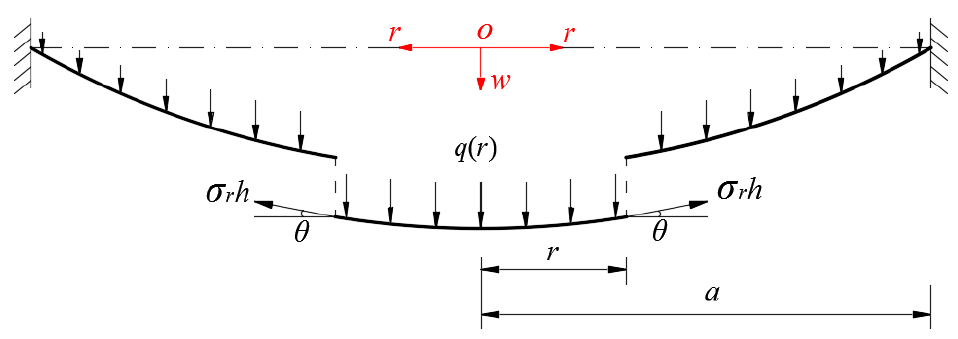
Figure 2. Free body diagram of the deformed circular membrane with radius 0 ≤ r ≤ a . Obviously, the external force F ( r ) produced by q ( r ) within radius r is equal to the weight of the liquid within radius r , and is given by (cid:90) r F ( r ) = ρ g r r F r where g is the acceleration of gravity and w ( r ) is the transverse displacement at r . Equation (1) is the usually so-called fluid-structure coupling equation at static equilibrium. The direction of the external force F ( r ) is always perpendicular to the plane in which the initially flat circular membrane is located and vertically downward. Right here, the vertical upward force is 2 π r σ r h sin θ , that is, the vertical component of the total membrane force 2 π r σ r h at r . Therefore, after ignoring the weight of the circular membrane, the equilibrium condition in the vertical direction, i.e., the so-called out-of-plane equilibrium equation, is given